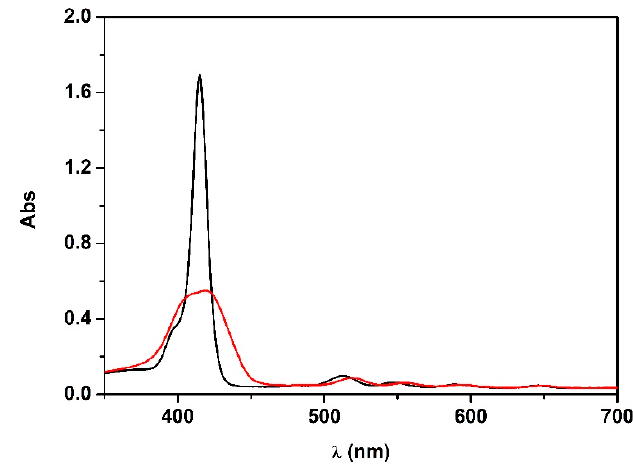
/ v (red line). 2 O 1:9 v